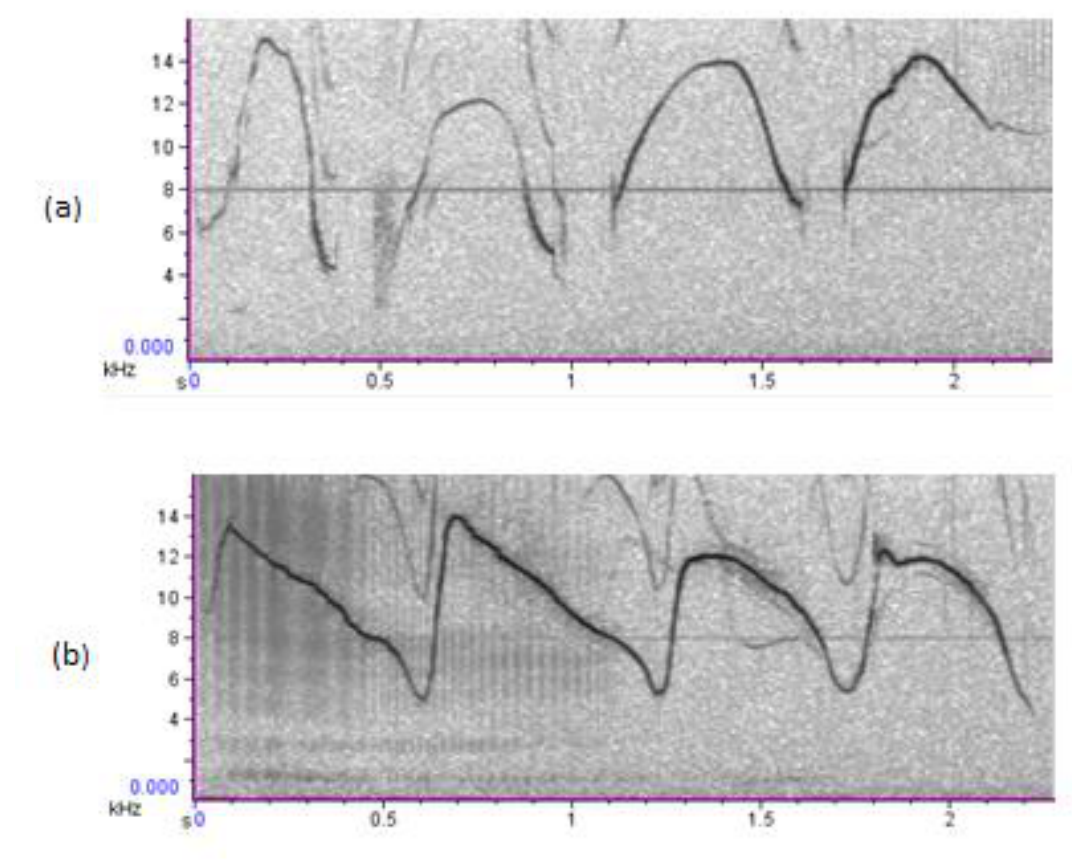
Figure 1. Example spectrograms of whistles used in the current study that were classified as showing either (a) no overlap with other vocalizations, or (b) minimal